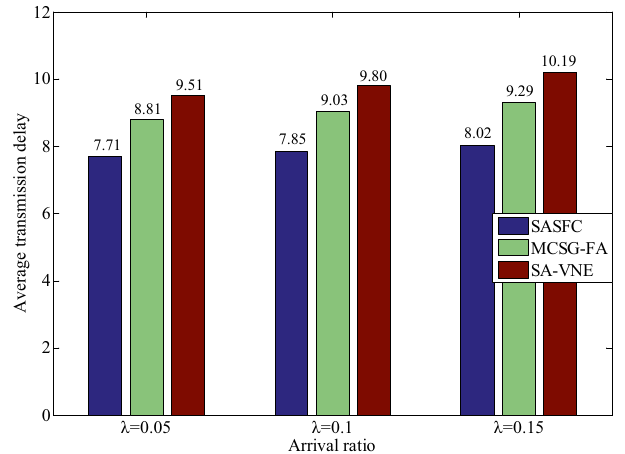
Figure 9. Average transmission delay.